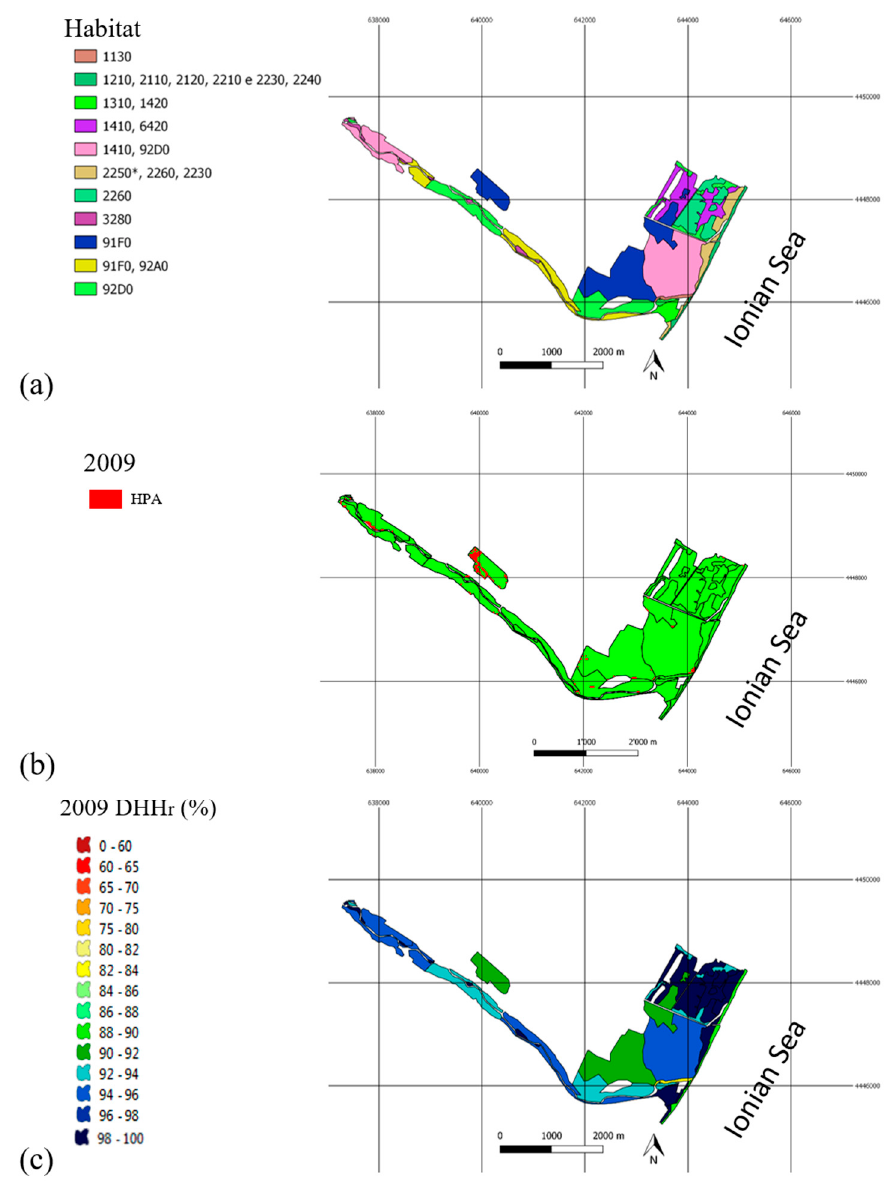
Figure 8. Bosco Pantano di Policoro SAC: ( a ) Map of habitats; ( b ) map of habitat priority areas; ( c ) map of the degree of habitat consistency (DHC) index. Maps ( b , c ) are obtained on the statistics of 2009 data at SAC level.